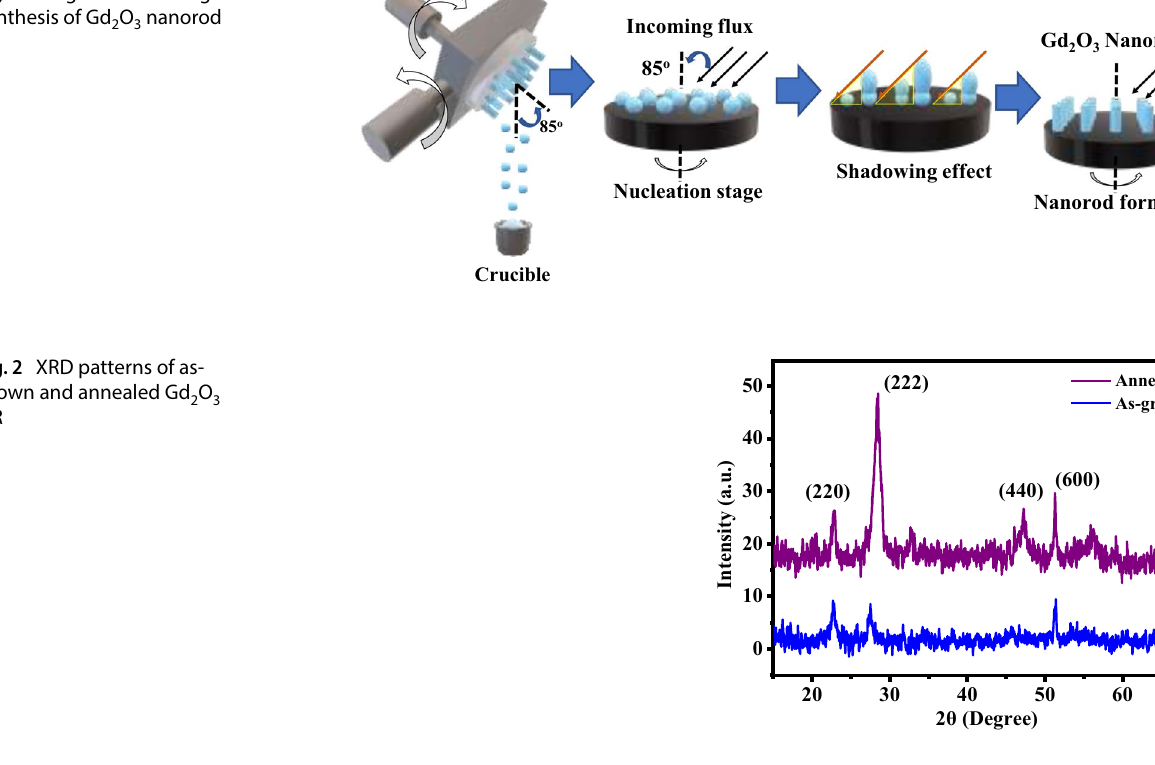
Fig. 1 Diagram illustrating the synthesis of Gd